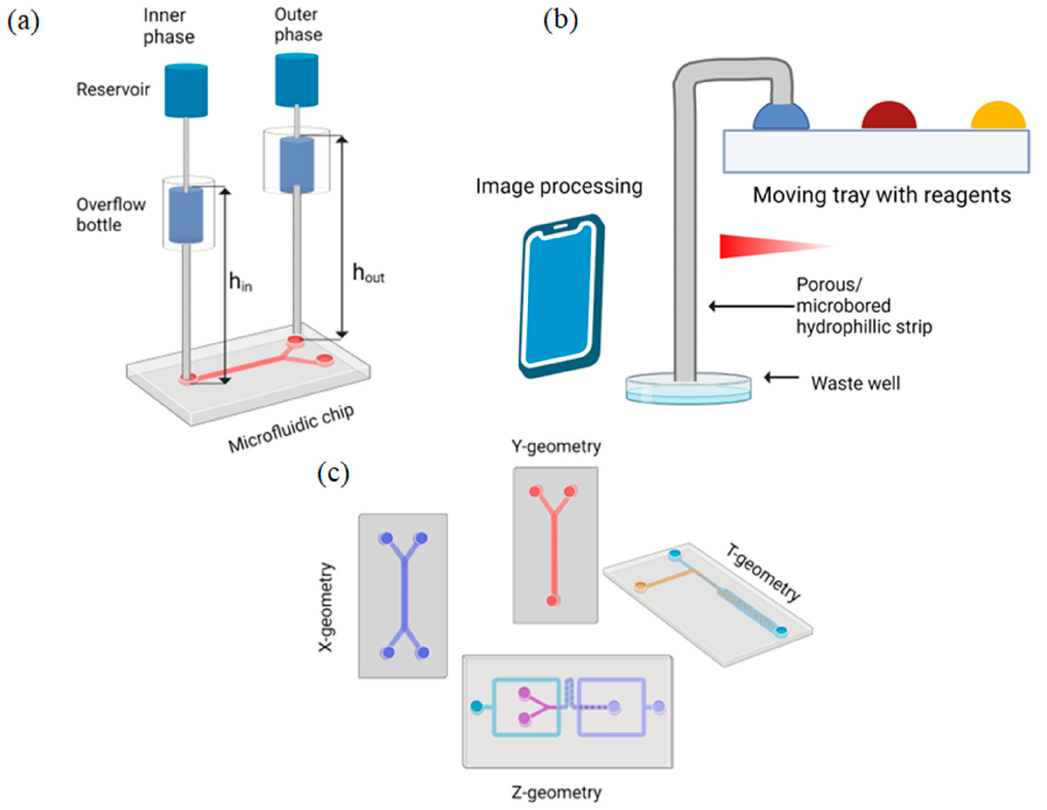
Figure 1. Schematic illustrations of gravity-driven systems: ( a ) semi-open gravity-driven overflow microfluidic flow supply system; ( b ) gravity-driven microfluidic siphon; ( c ) stand-alone pressure- driven 3D microfluidic chemical-sensing analytic device with different channel geometries.